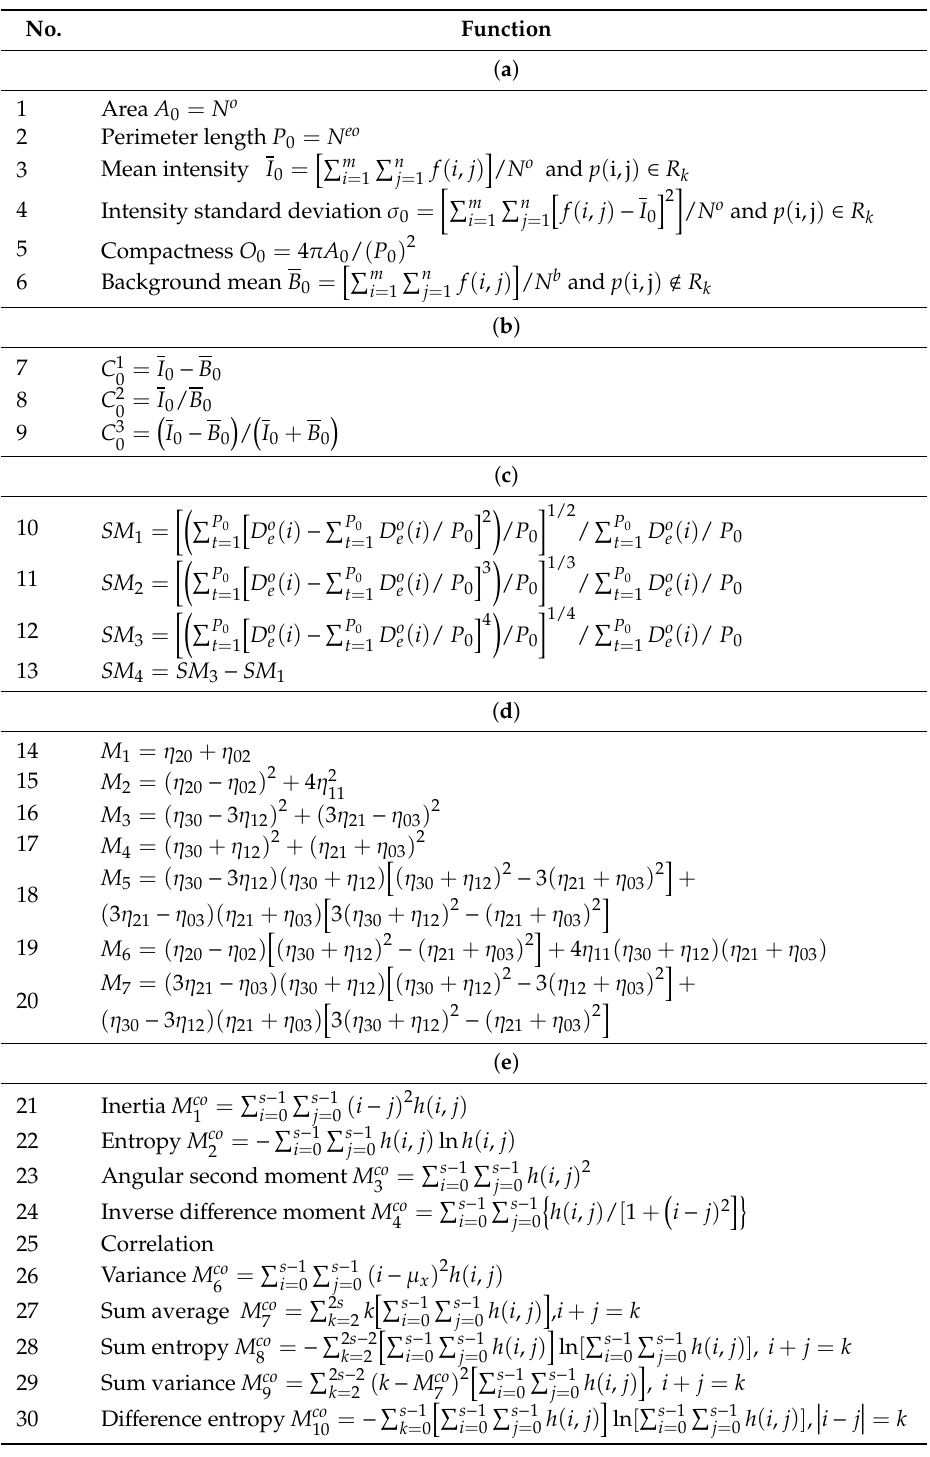
Table 2. ( a ) Basic features of regions. ( b ) Contrast features of regions. ( c ) Shape moment features of regions. ( d ) Moment-invariant features of regions. ( e ) Statistical-texture features of